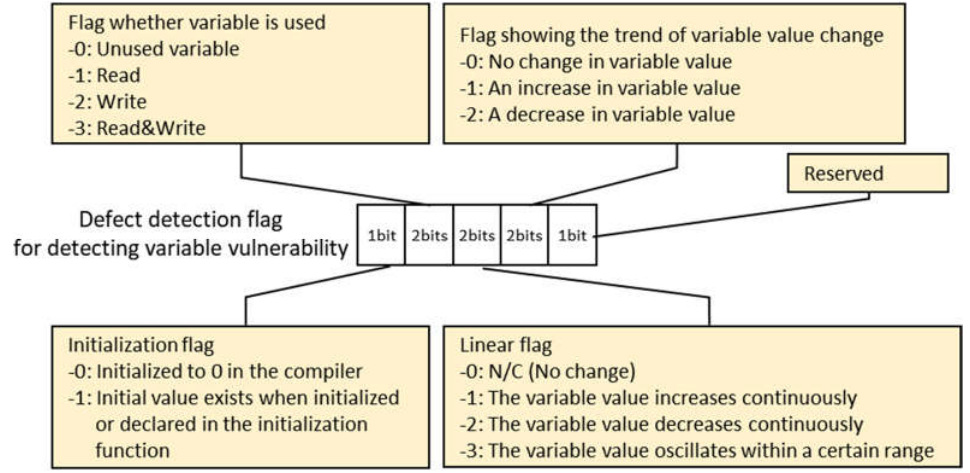
Figure 5. Defect detection flag.